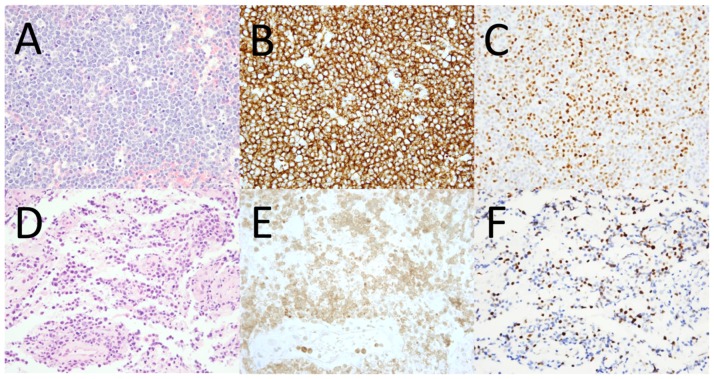
Representative examples of patterns of CNS DLBCL infiltration and MYC protein expression.H&E-stained section of a CNS DLBCL exhibiting a diffuse pattern of infiltration (A), CD20 expression (B), and MYC expression by 80% of neoplastic cells (C). H&E-stained section of a CNS DLBCL exhibiting a perivascular pattern of infiltration (D), CD20 expression (E), and MYC expression by 30% of neoplastic cells (F). All photomicrographs were taken at 40x magnification.